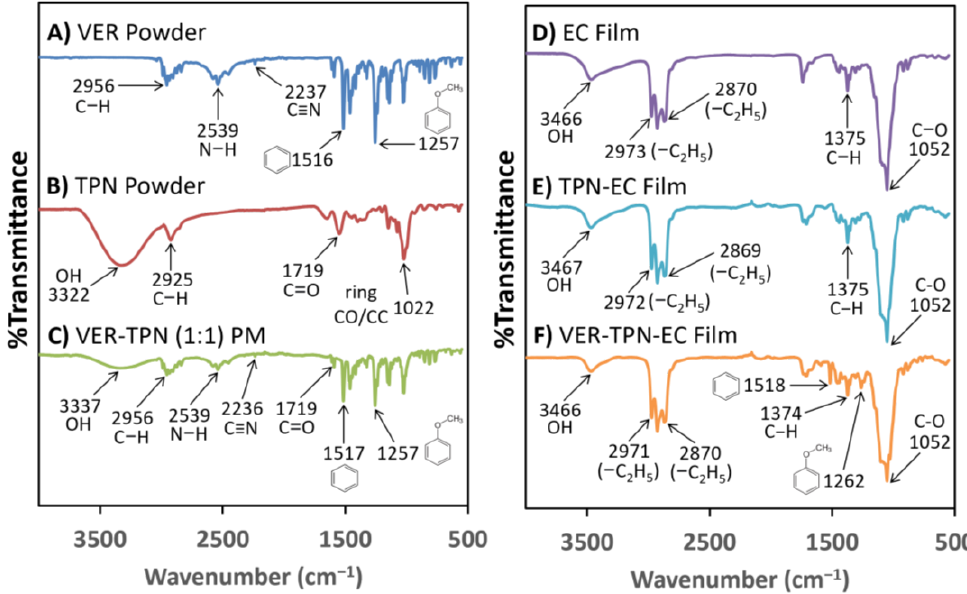
Figure 3. FTIR spectra of ( A ) pure VER powder, ( B ) pure TPN powder, ( C ) VER-TPN (1:1) powder mix (PM), ( D ) EC film, ( E ) TPN-EC film, and ( F ) VER-TPN (1:1)-EC film. Major peaks are denoted and further explained in the text.